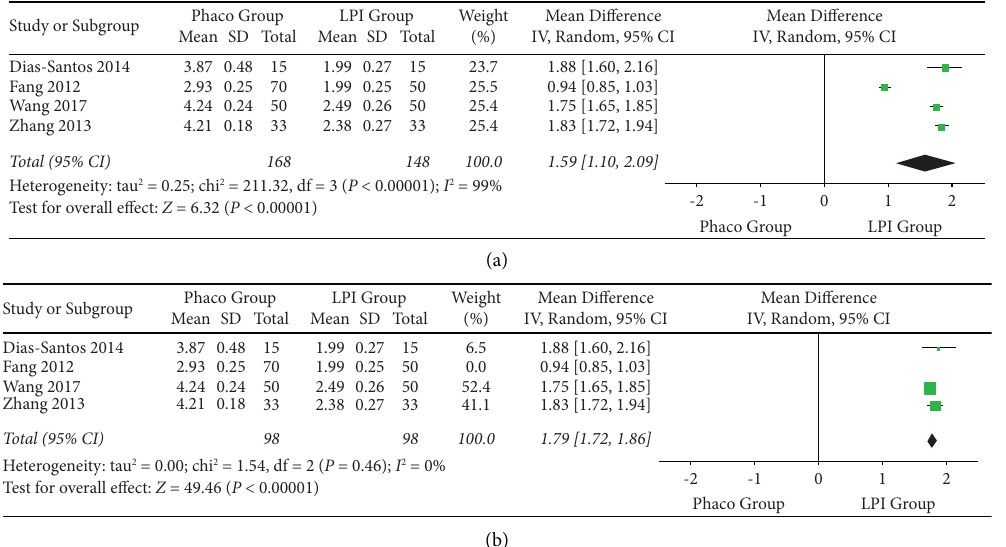
Figure 4: Forest plots comparing the ACD between the Phaco groups and LPI groups after operation. (a) Tree months after the operation. (b) Tree months after the operation (excludes the study of Min et al.